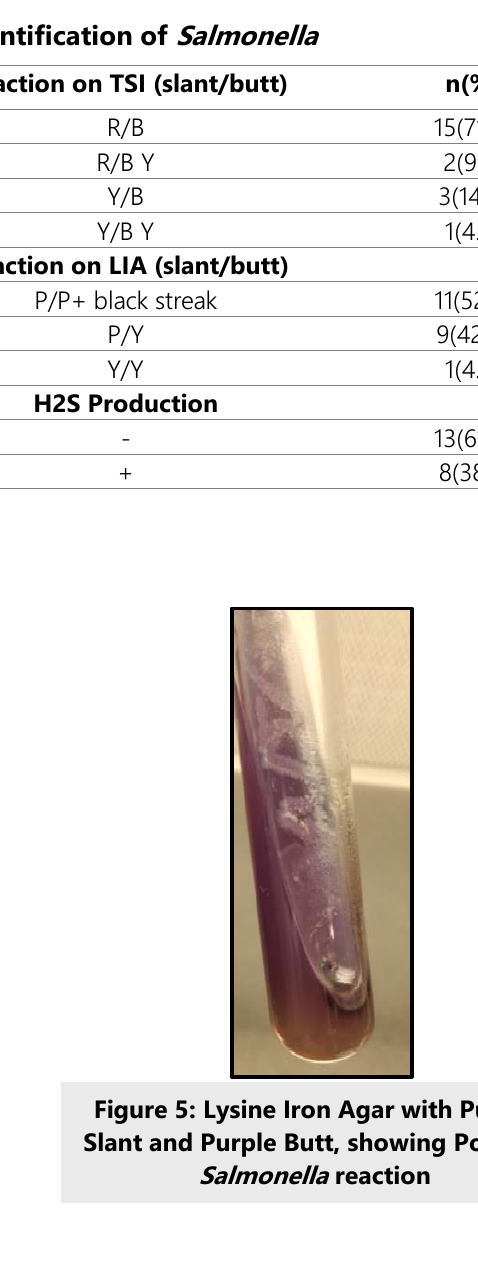
Figure 3: Enlarged Separated Colonies of Salmonella on BS Agar